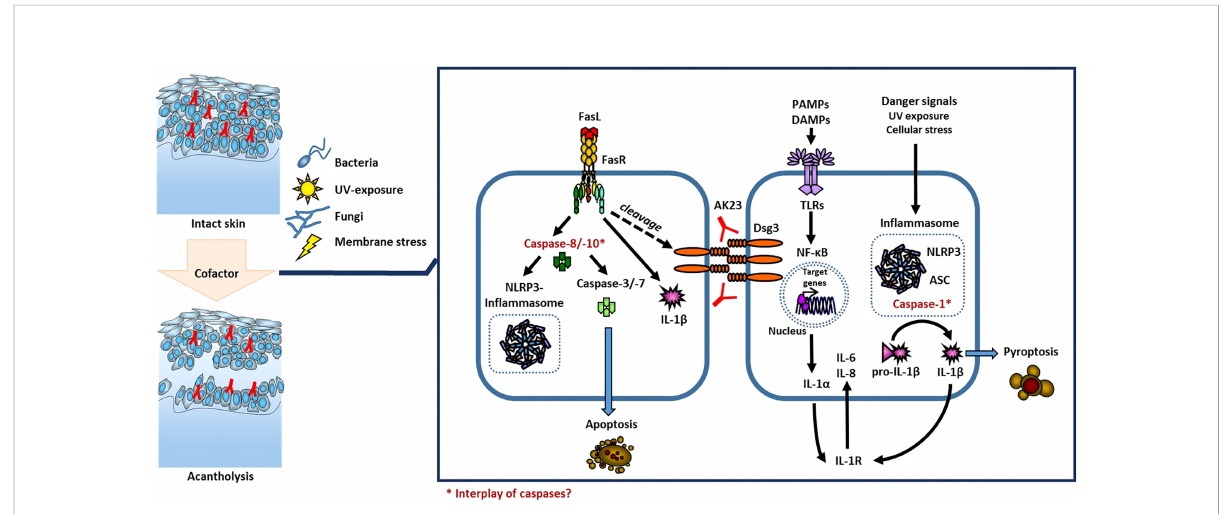
FIGURE 2 Model of cofactor in fl uenced acantholysis in PV. The local activation of the innate immune system through activation of TLRs and in fl ammasomes or via activation of caspases is known in